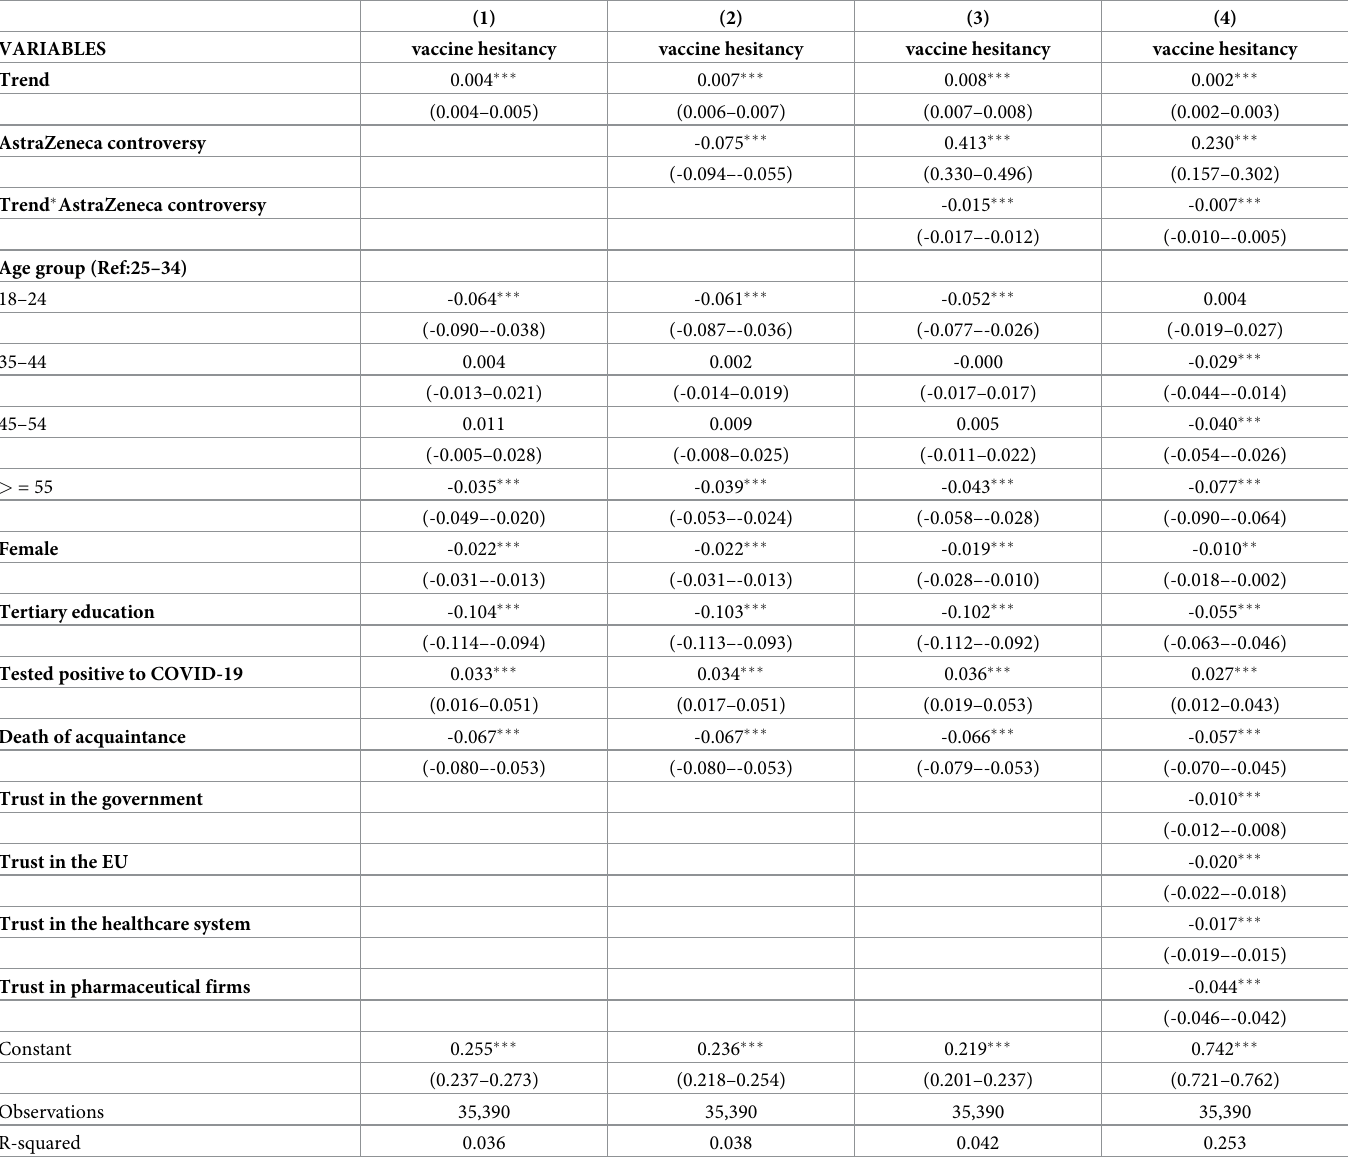
Table 1. Vaccine hesitancy trend